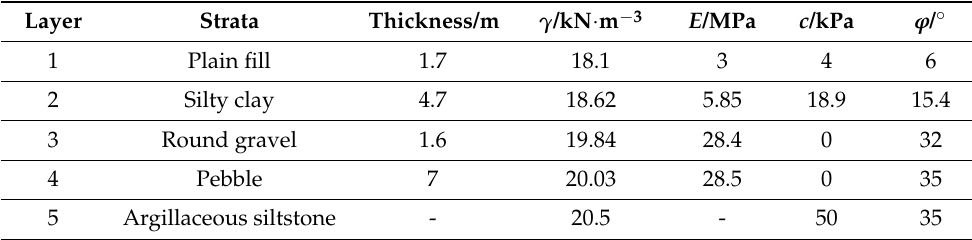
Figure 2. Test pile. Table 1. Soil parameters. Table 1. Soil